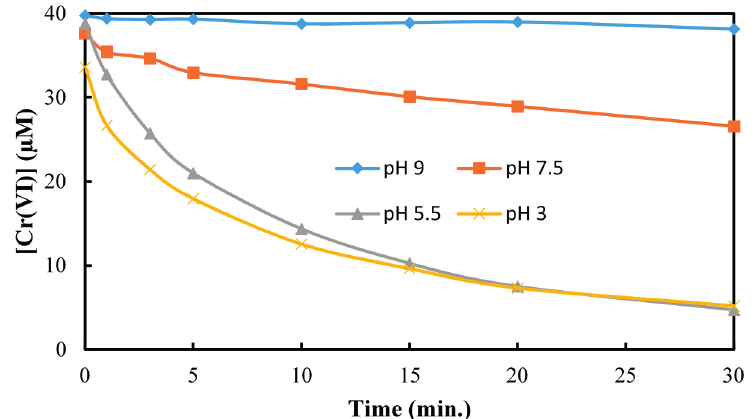
Figure 9. Cr(VI) reduction at different Cr(VI):As(V):Cu(II) ratios. pH = 3, [TiO 2 ] = 0.10 g/L, 350 nm.